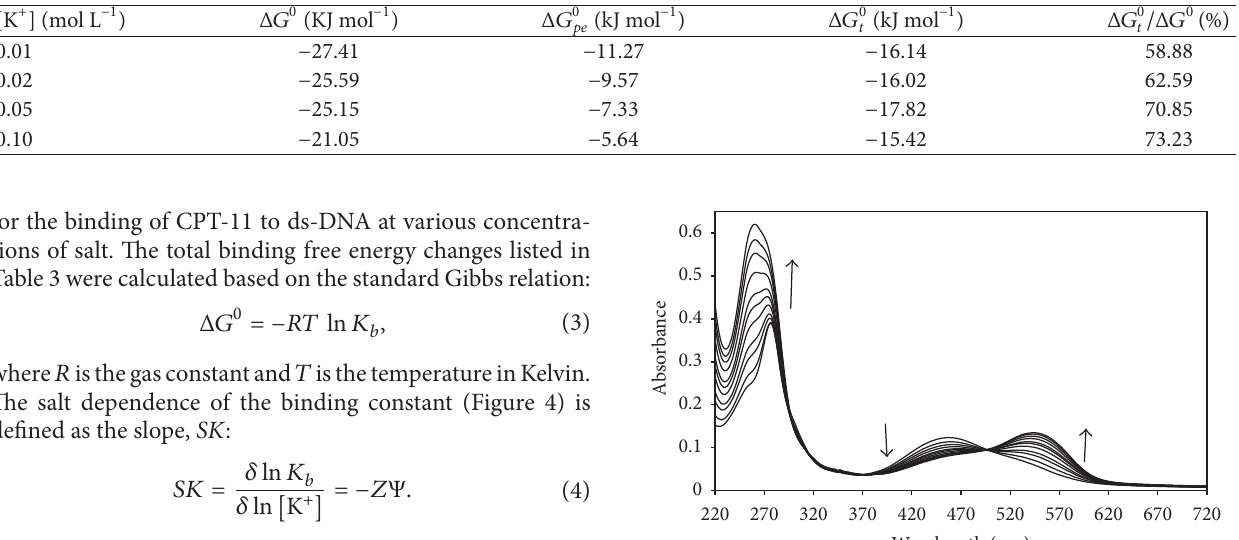
Wavelength (nm) = 0.0, 6.7, 13.4, 20.1, 26.8, DNA 𝐶𝐶